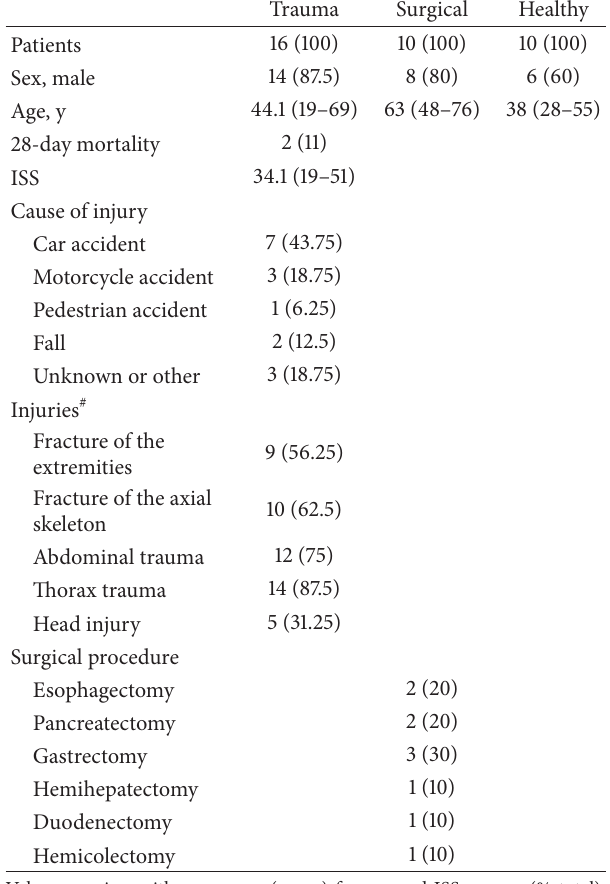
Table 1: Baseline characteristics of the three investigated